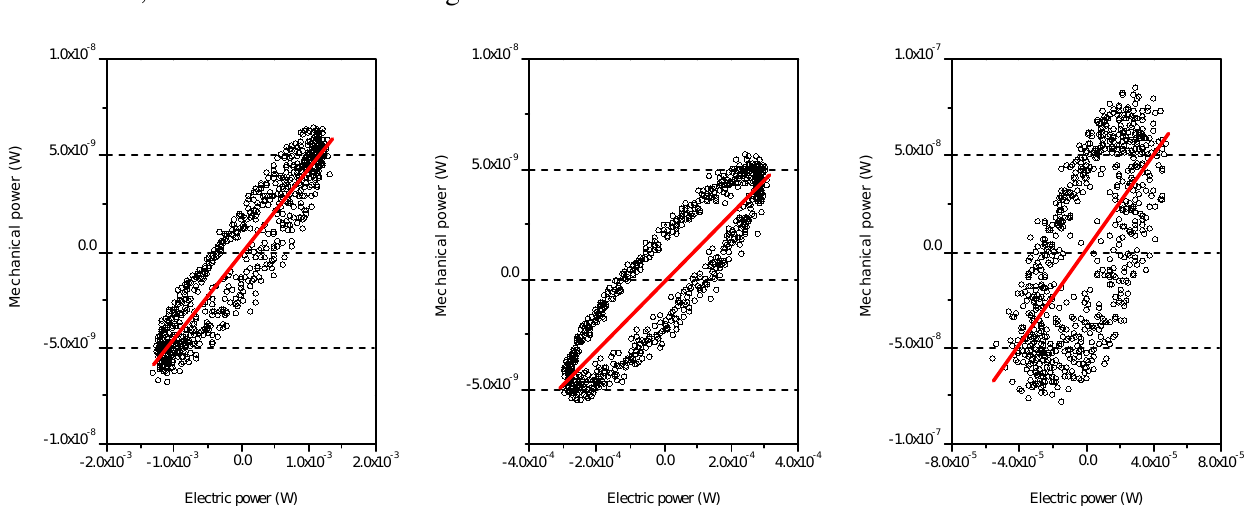
Figure 4. The instantaneous mechanical power changed against instantaneous electric power of P1, P2 and P3 from left to